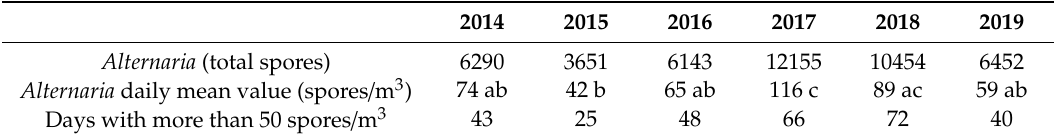
Table 3. Aerobiological data expressed such as total Alternaria and mean Alternaria concentration by potato growing